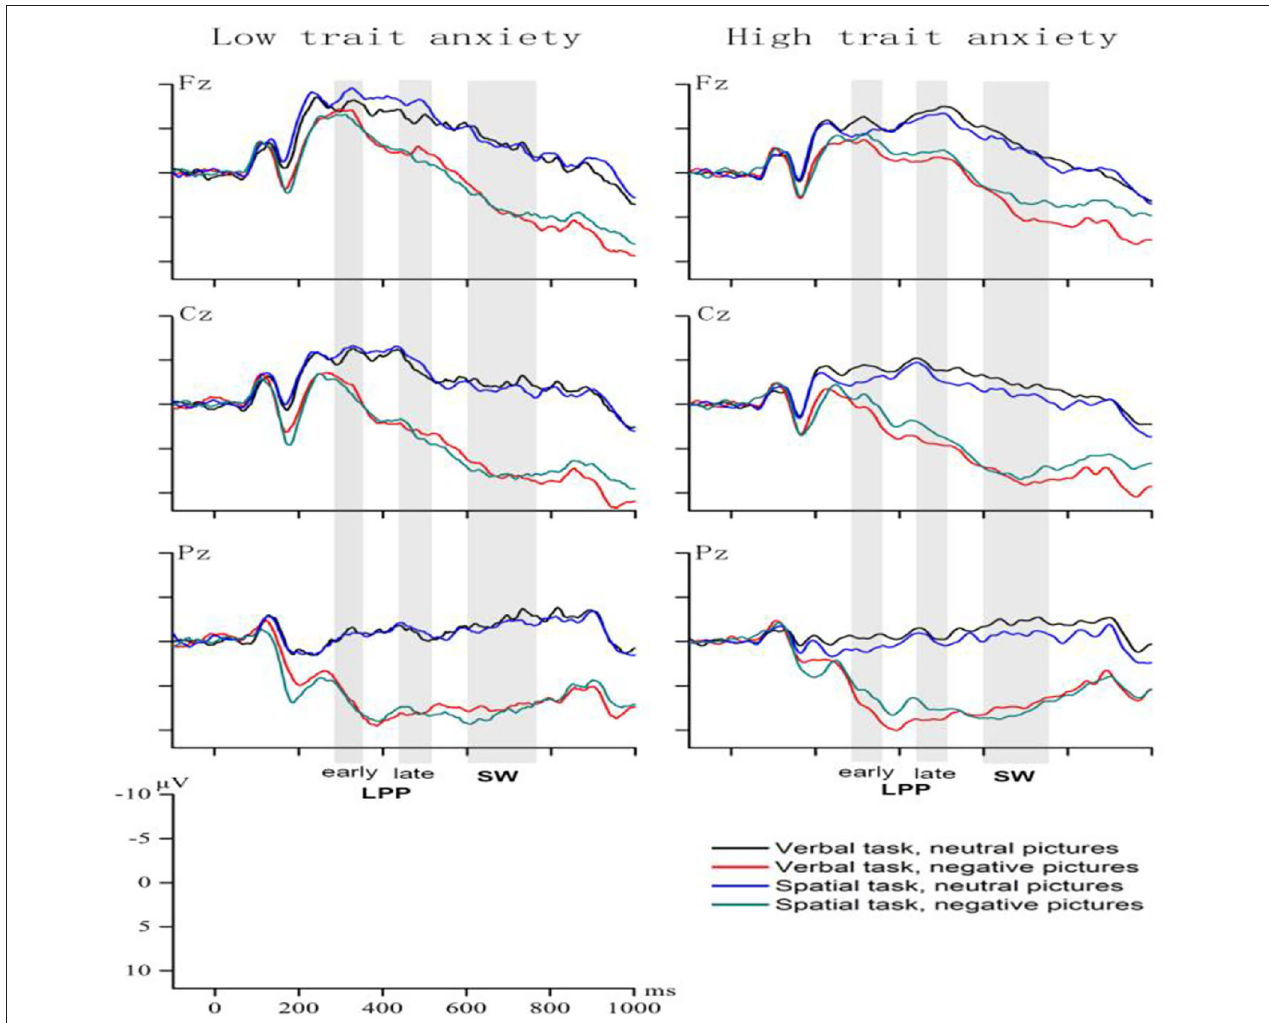
FIGURE 2 | Grand-average waveforms in the LA and HA groups under the four